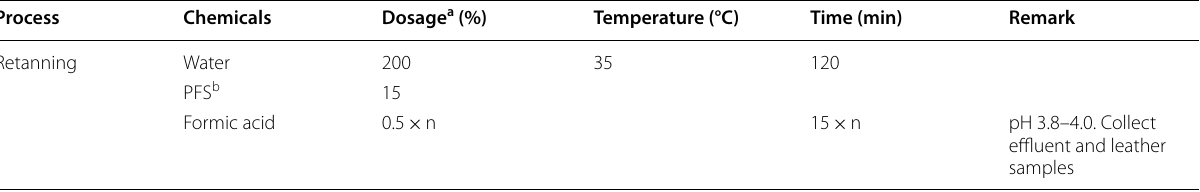
a The percentage of chemicals was based on the weight of shaved wet blue b The PFSs were the prepared PFS-18, PFS-33, PFS-50, PFS-63, and PFS-74, respectively (number presents DS)